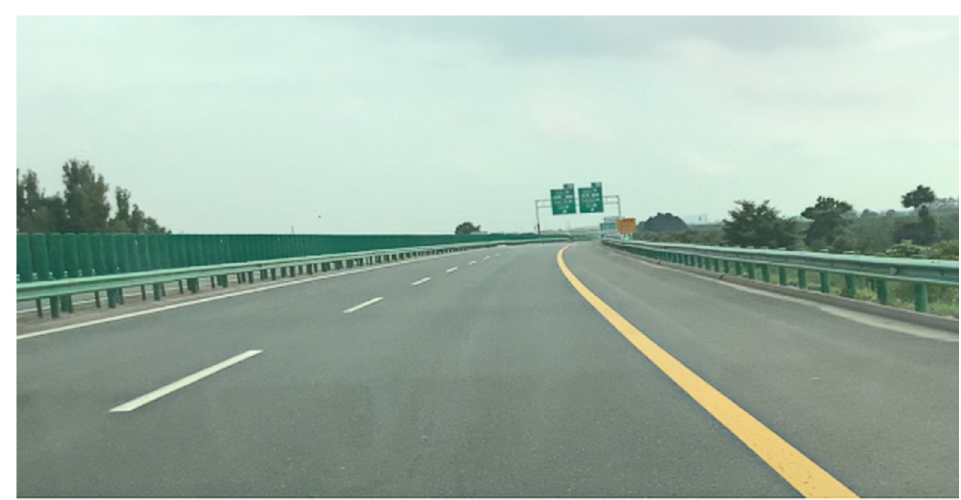
Fig 4. Schematic diagram of real road (S-shape curve).